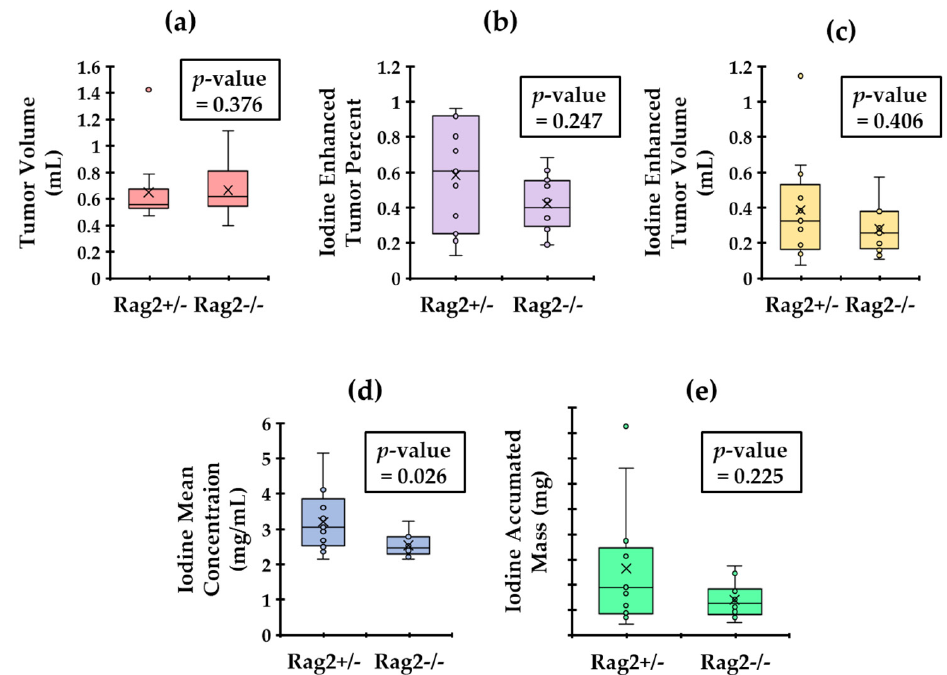
Figure 4. Calculated tumor metrics with the associated p-value from an unpaired Wilcoxon–Mann– Whitney test. We display the comparison of tumor volume ( a ). We also show plots of the Iodine enhanced tumor volume ( b ), the enhanced tumor percentage ( c ), the mean iodine concentration ( d ) and the iodine accumulated mass ( e ) in tumors. Only the mean iodine concentrations are significantly different between the two genotypes ( p < 0.05).